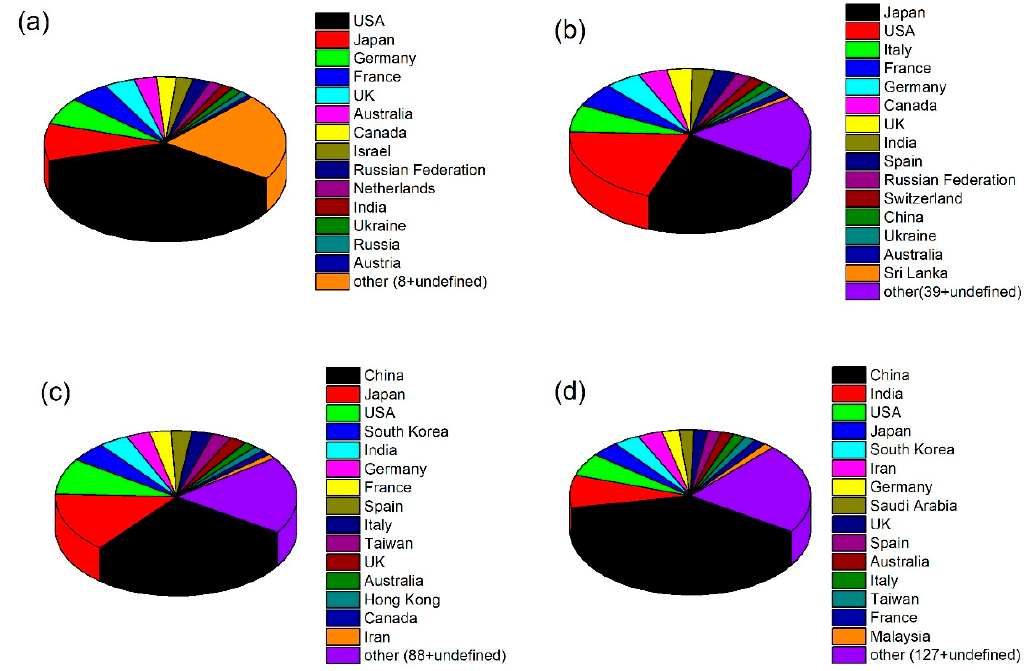
Figure 2. Relative weight of the affiliation country for the documents indexed as “photocatal*” divided into the four periods proposed: ( a ) Pioneering years (until 1980), ( b ) Maturity (1981–1995), ( c ) Explosion (1996–2010) and ( d ) Inflation (2011–2021) (database: Scopus, 20 September 2022). The papers published in the field of photocatalysis (“photocatalysis” in the title, ab- stract or keywords) are still increasing every year, and this increase is still exponential, as witnessed by the linear trend observed in the logarithmic plot of Figure 3. The growth was